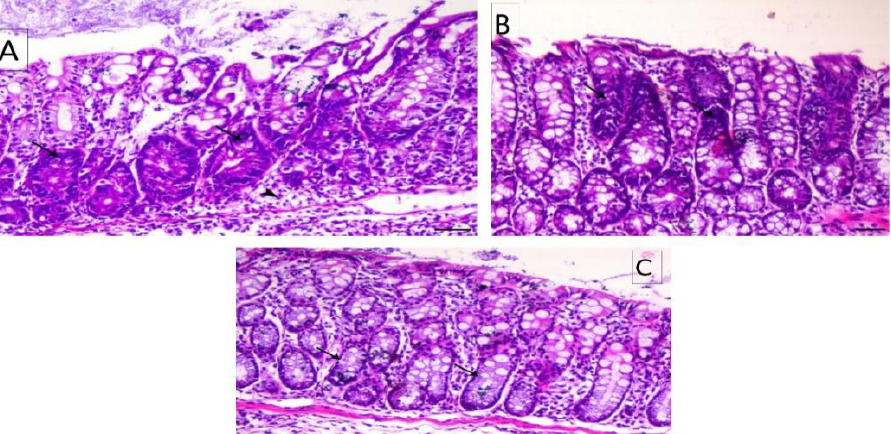
Figure 7. Photomicrographs of colon section of mice stained with hematoxylin and eosin; ( A ): Section from colon of Group IV positive animal treated with DMH showing marked dysplasia of the intestinal crypts (arrows) and interstitial colitis associated with inflammatory cells infiltration, mostly lymphocytes and macrophages (arrowhead), H&E, ×200, bar = 50 μ m; ( B ): Section from colon of Group V showing decrease in both the dysplastic changes within the intestinal crypts (arrows) and interstitial inflammatory cells infiltration, H&E, ×200, bar = 50 μ m; ( C ): Section from colon of Group VI showing marked decrease of intestinal dysplasia changes (arrows indicate dysplastic glands), H&E, ×200, bar = 50 μ m.